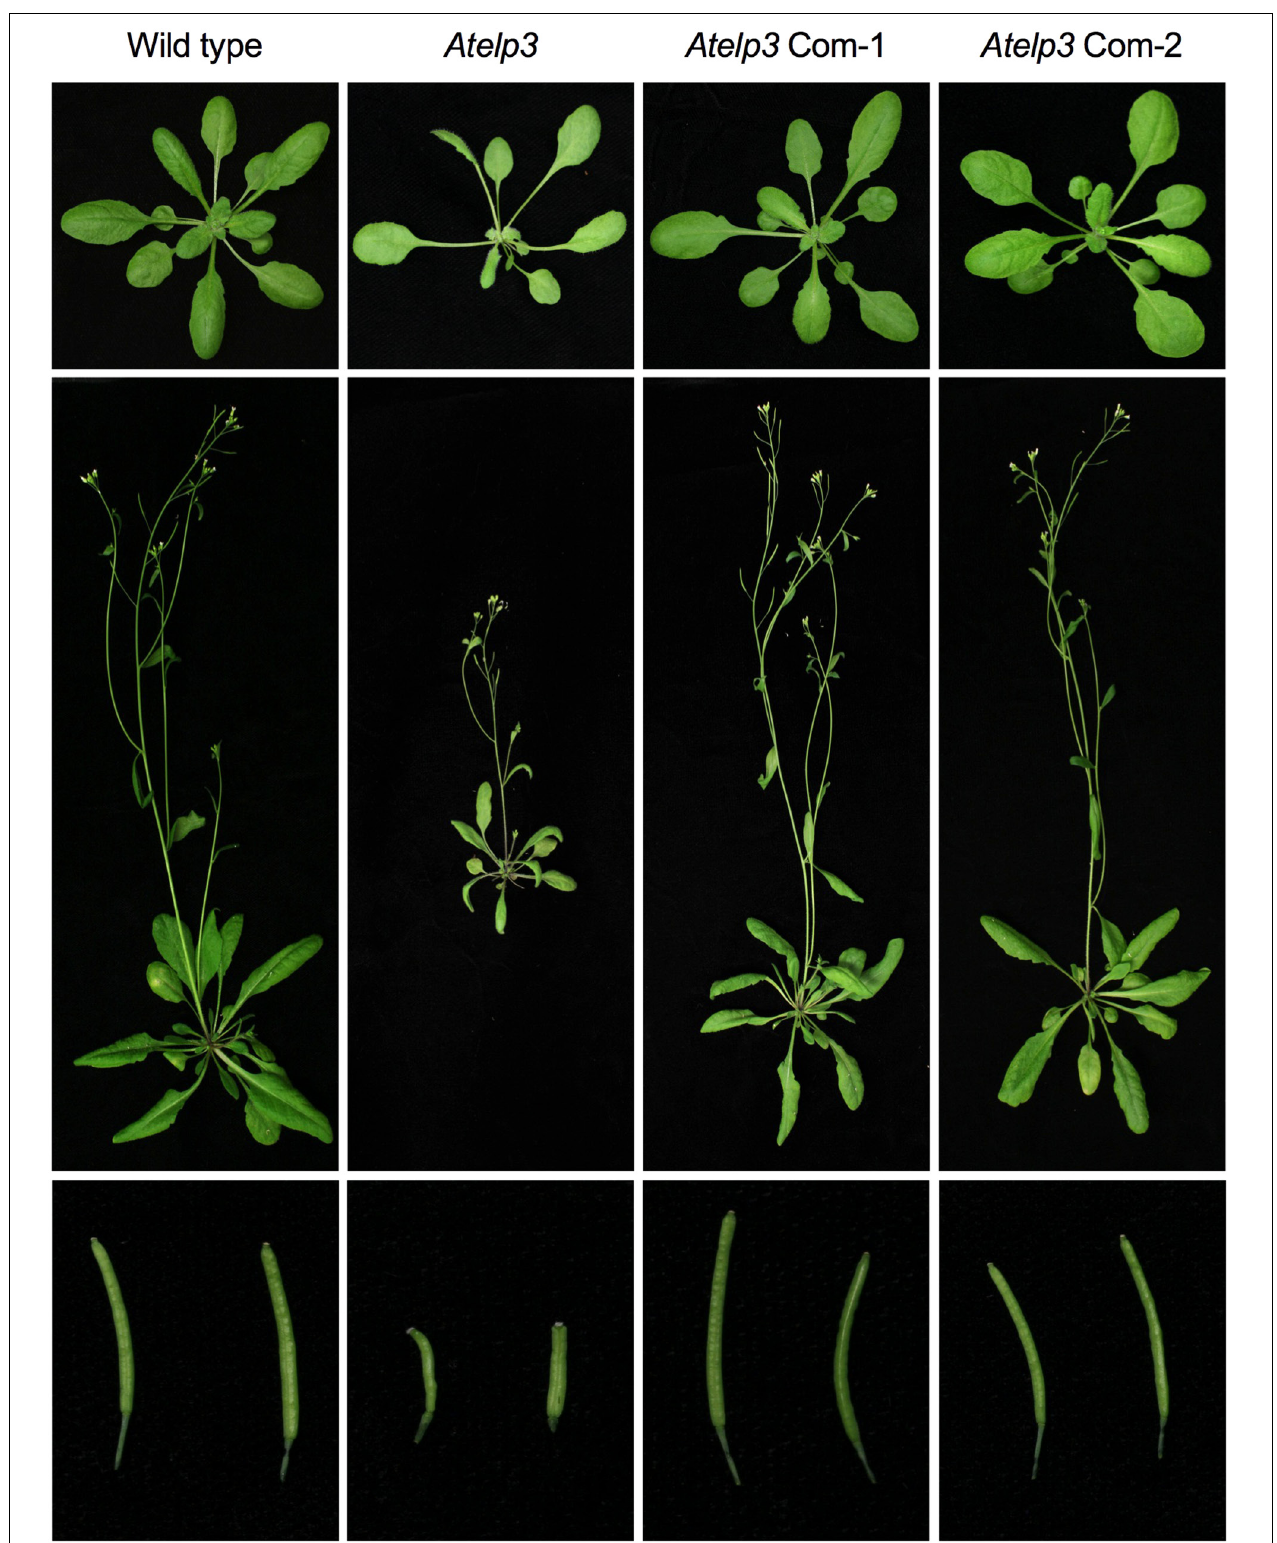
FIGURE 5 | Complementation of the Arabidopsis Atelp3 mutant by SlELP3 . Morphological phenotypes of Arabidopsis wild type, Atelp3 , and two independent complementation lines ( 35S::SlELP3 Atelp3 ): Atelp3 Com-1 and Atelp3 Com-2. (Top) 3-weak-old plants; (Middle) 6-week-old plants; (Bottom) siliques.